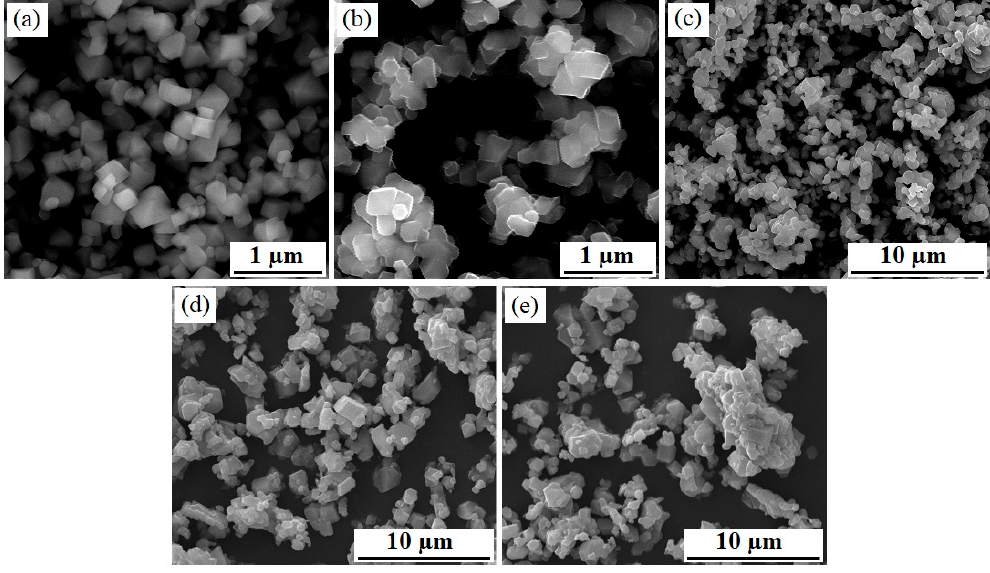
Figure 2. SEM images of ( a ) Mn 3 O 4 octahedra, ( b , c ) LiMn 1.95 Mg 0.05 O 4 octahedra, ( d ) LiMn 2 O 4 , and ( e ) LiMn 1.95 Mg 0.05 O 4 .